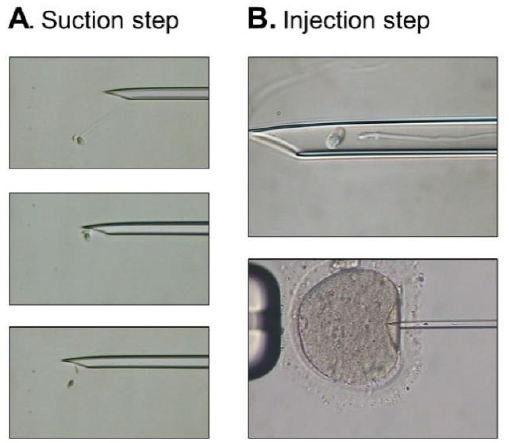
Figure 6. Intracytoplasmic sperm injection (ICSI) procedure using selected sperm from subject P0504. ( A ) A complete spermatozoon showing progressive motility was selected. Gentle immobili-